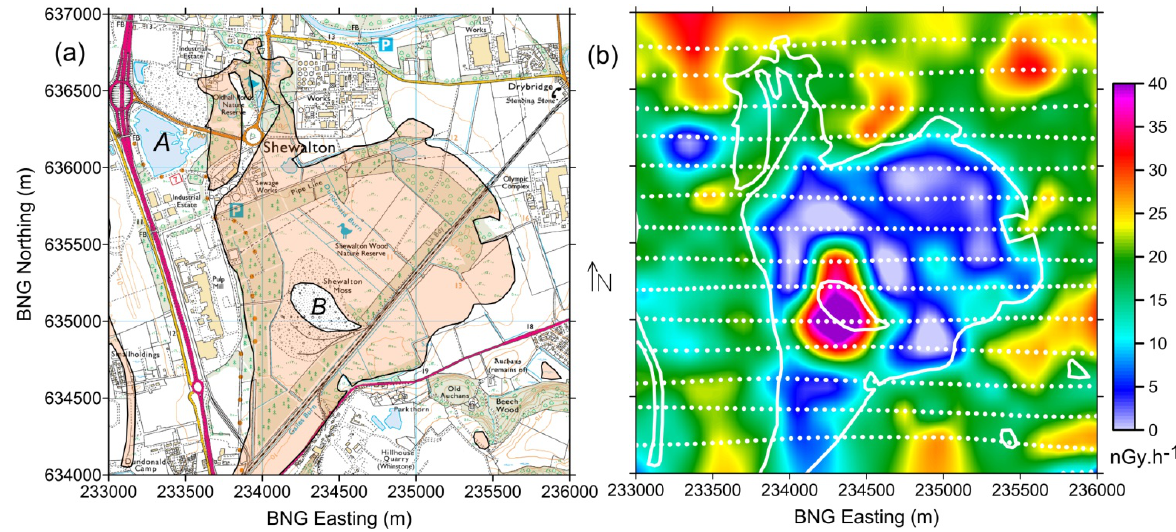
Figure 4. The 3 × 3 km detailed study area from the Ayrshire survey. ( a ) 1:50 k base topographic map with peat areas shown with transparent infill. “A” denotes a water body and “B” identifies a landfill. ( b ) Colour image of the radiometric DOSE data with peat outline in white. White dots denote airborne survey sampling along E–W flight